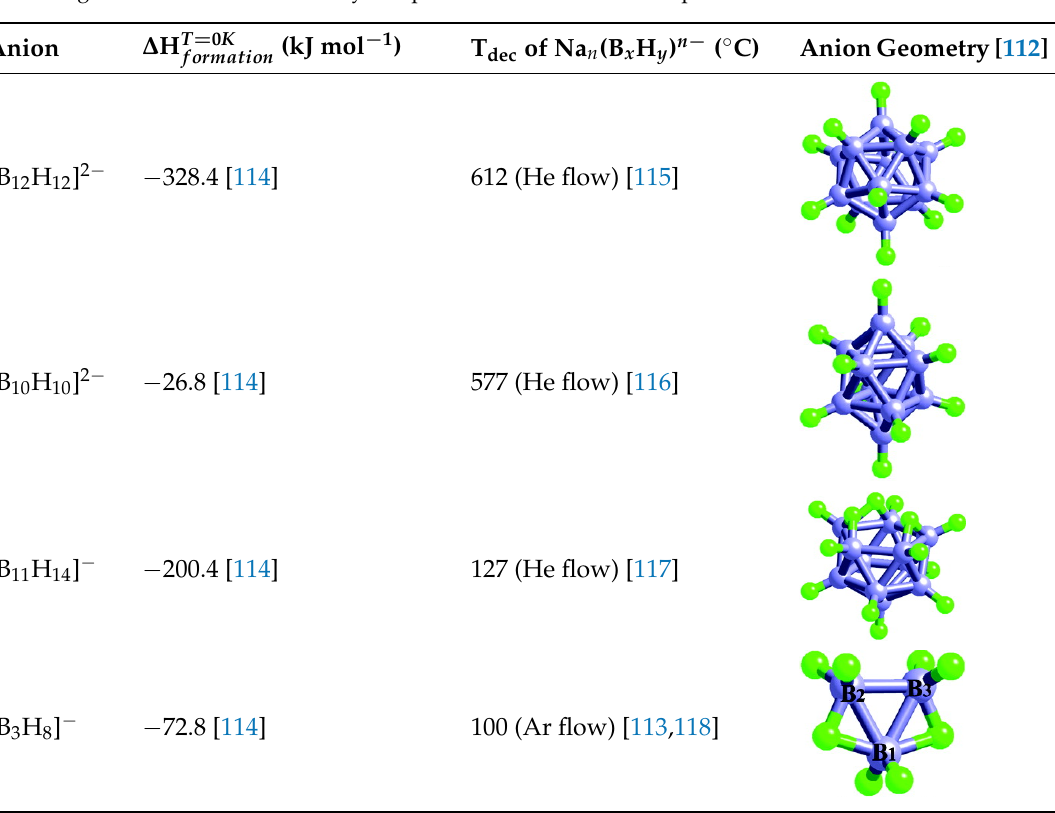
Table 5. Key structural and thermodynamic properties tabulated for a range of polyborane anions that have been investigated as intermediate phases during borohydride decomposition. The theoretically predicted enthalpy of formation ( ∆ H formation ) at T = 0 K is given for the gas phase formation of each anion. An approximate decomposition temperature (T dec ) is given for the sodium salt (Na n (B x H y ) n − ) of the given anion to allow for easy comparison between different